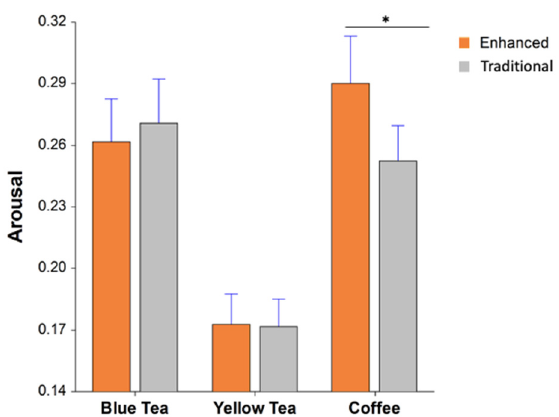
Figure 9. Appl. Sci. 2020, 9, x FOR PEER REVIEW